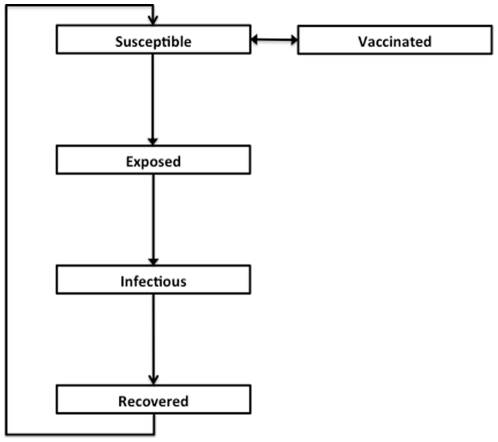
Outline of model structure, showing population flows between compartments.Each compartment is further stratified by age category.